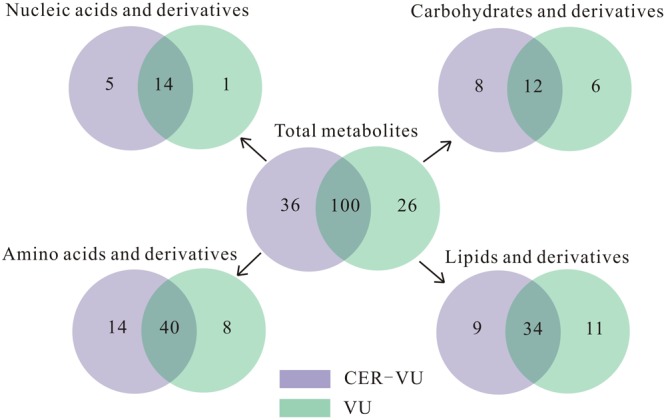
Metabolite numbers of C. albicans biofilm EM via untargeted filtration using cation exchange resin (CER) plus vortexing and ultrasonication (CER-VU, light purple) at pH 7.8 and vortexing plus ultrasonication (VU, light green) under continuous flow state. The metabolites were classified into four groups: lipids and derivatives, carbohydrates and derivatives, amino acids and derivatives, and nucleic acids and derivatives.